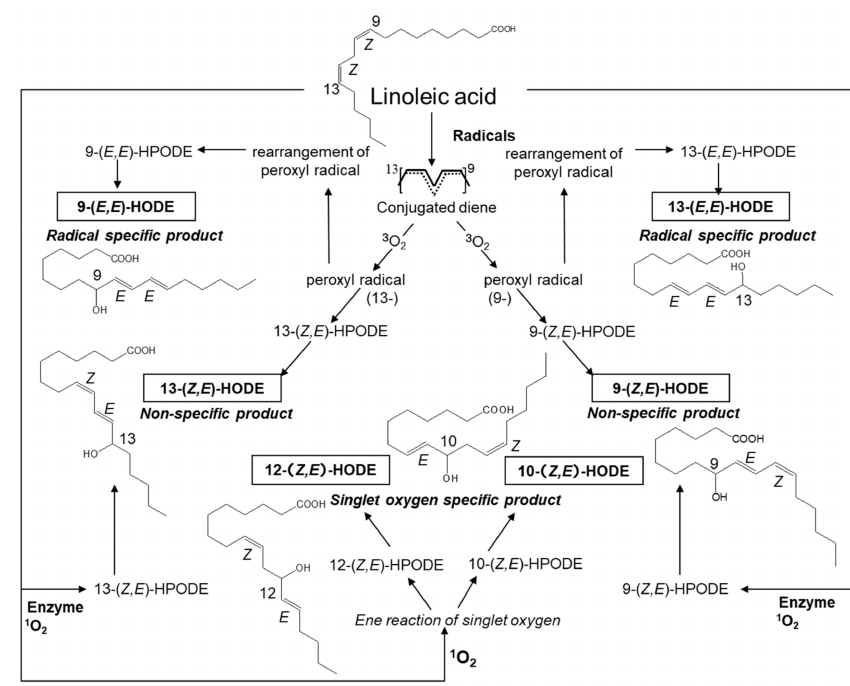
Figure 1. Chemical structures of HODE